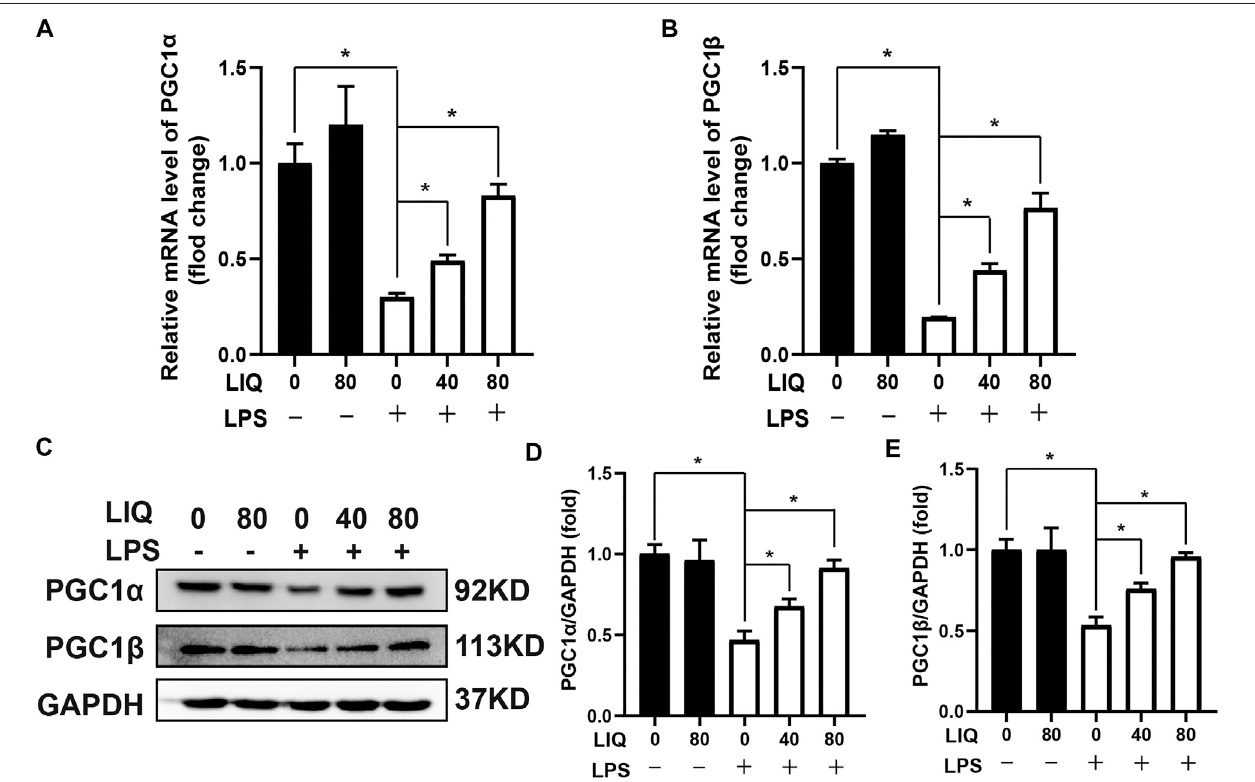
FIGURE5 | LIQ treatment improved fatty acidmetabolism. RT-PCR wasperformed toanalyze the mRNA expression offatty acidmetabolism associated genes in mouse hearts, including (A) PGC1 α , (B) PGC1 β , mRNA of GAPDH was used as internal reference ( n (cid:2) 6), (C) Representative western blots images of PGC1 α , PGC1 β and GAPDH, relative quantitative analysis of PGC1 α /GAPDH (D) , PGC1 β /GAPDH (E) ( n (cid:2) 6). Data were presented as the Mean ± SEM. * p < 0.05 compared with the indicated group, the data were expressed as the Mean ± SEM and were compared by one-way ANOVA with Tukey post hoc